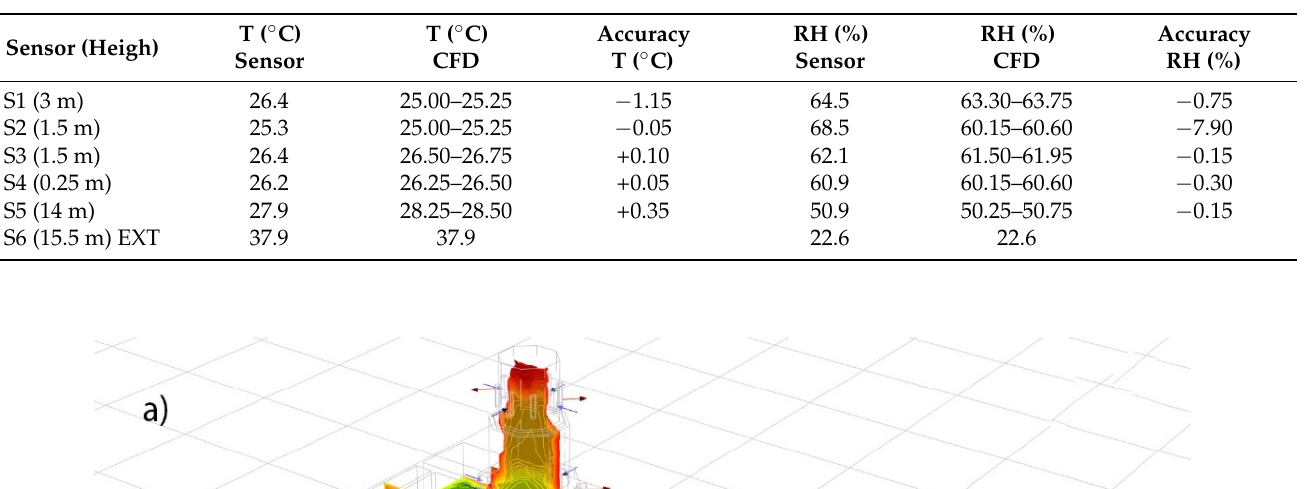
Table 10. Comparison of temperature and relative humidity in the case of winter.